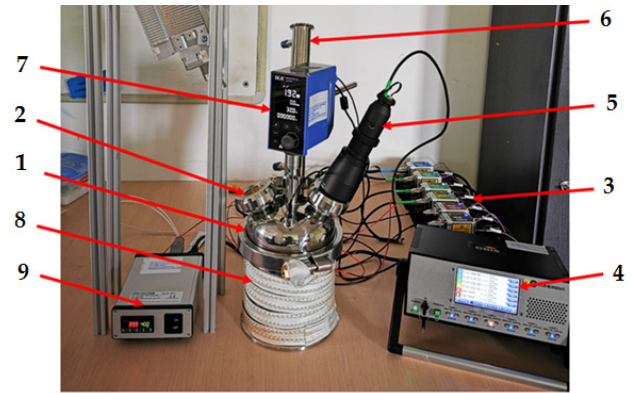
Figure 2. Laser-assisted extraction installation in the study. (1) Bio-reactor; (2) ZnSe observation and collecting sample window; (3) laser kit (488, 514, 532, 552, 660, and 785 nm); (4) laser controller (gathering the six laser beam in the study); (5) telescope (placed in front of the second quartz irradiation window); (6) cooling system (using current water); (7) agitation system (vertical stirrer); (8) heating system (tape heating); (9) heating